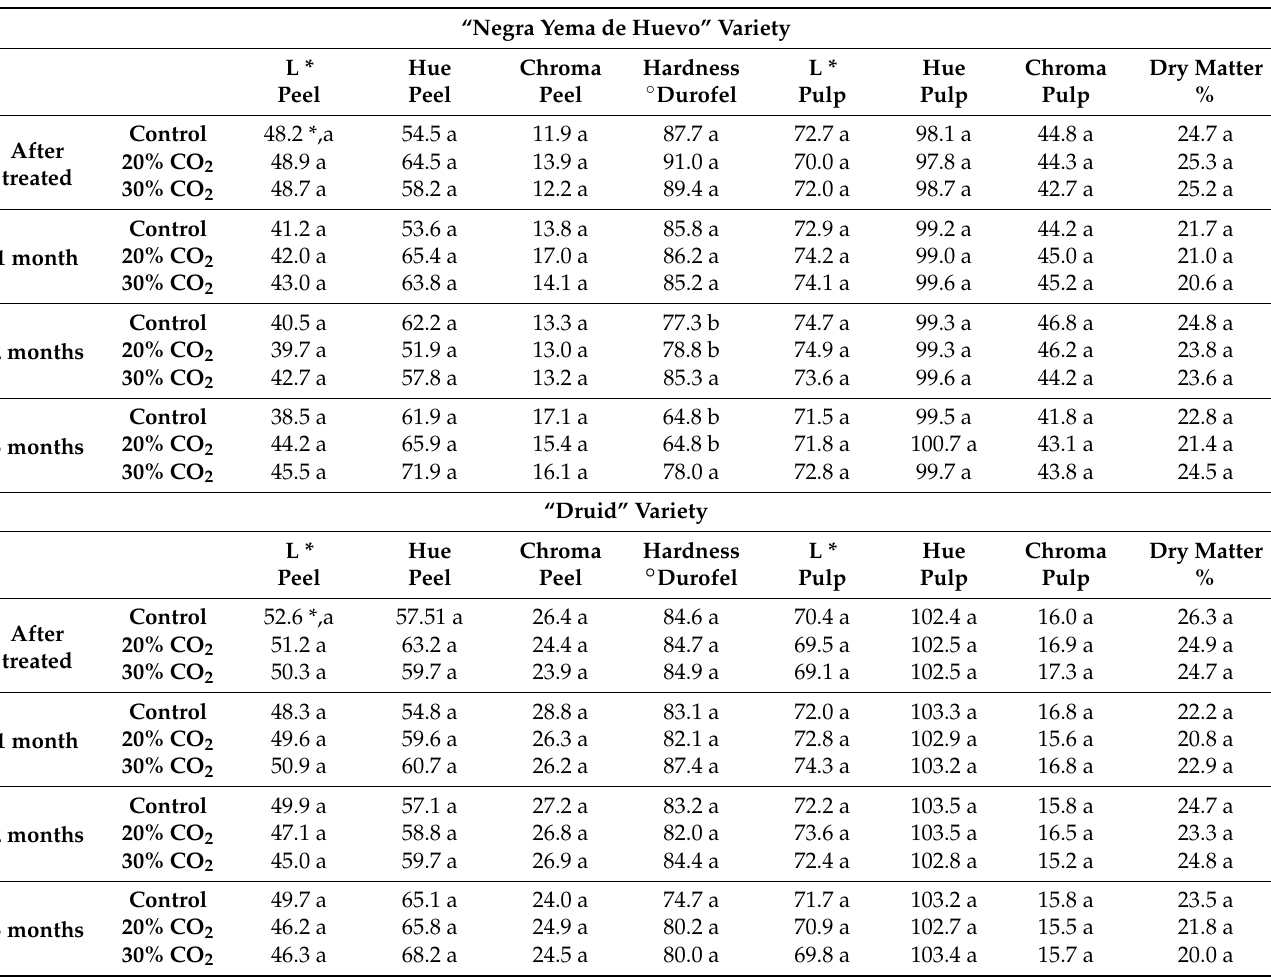
Table 2. Effect of 10-day 20 or 30% carbon dioxide-controlled atmosphere treatments at 20 ◦ C on potato (“Negra Yema de Huevo” and “Druid”) postharvest behaviour at 0, 1, 2, or 3 storage